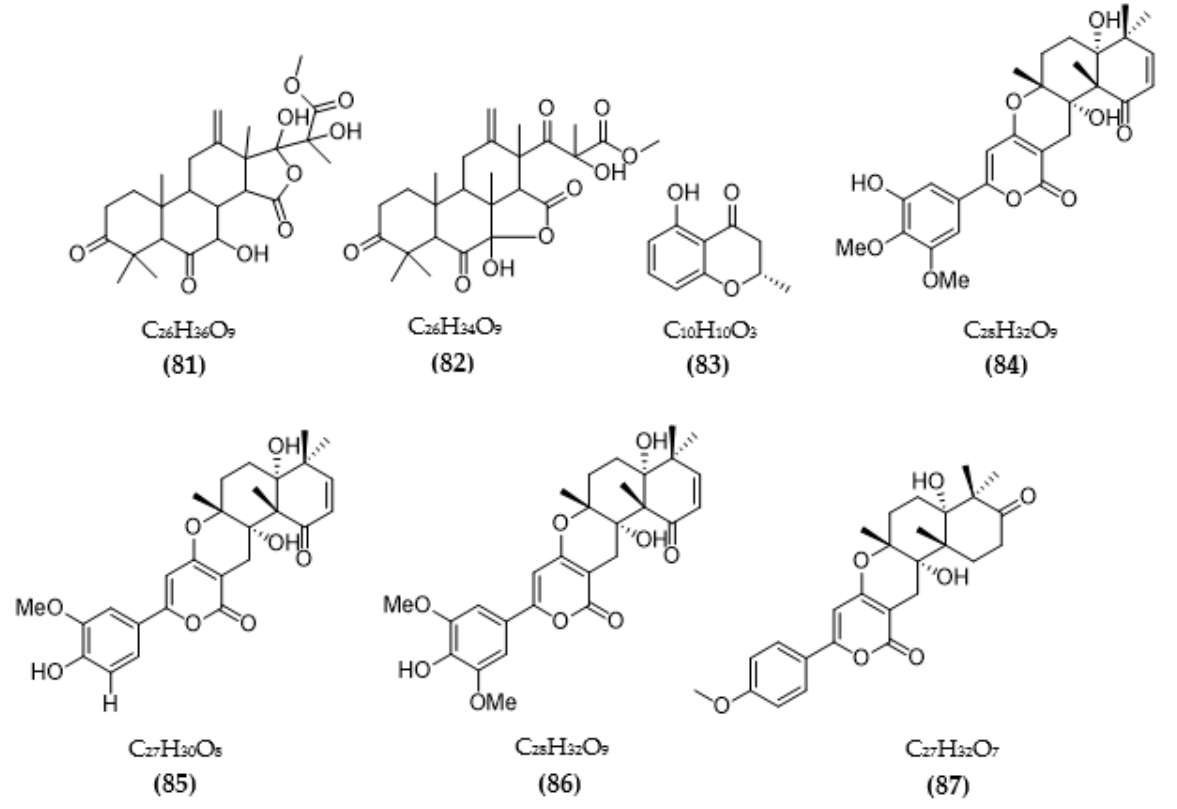
Figure 3. The chemical structures and chemical formula of ChE inhibitors from fungi.